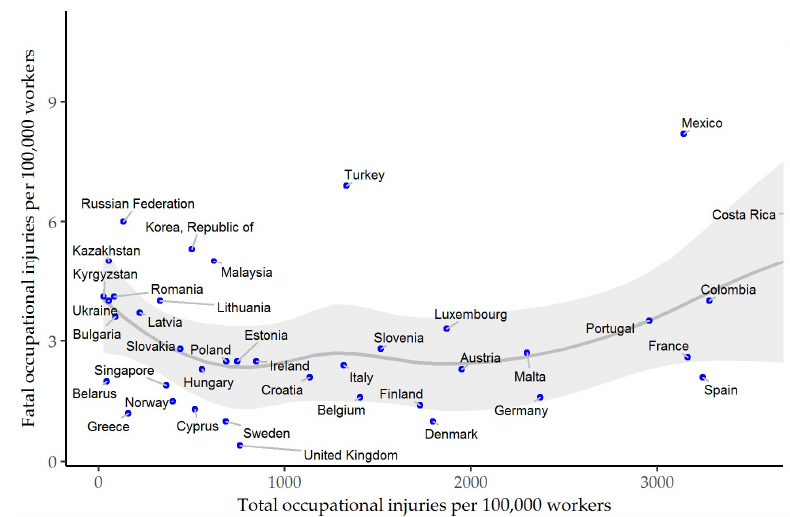
Figure 1. The number of total and fatal occupational injuries per 100,000 workers of each country from the data of ILOSTAT in 2015. Note: The values of Costa Rica are not shown in figure for clarity (Costa Rica: total occupational injury rate = 8922.5; fatal occupational injury rate = 6.9). The grey line indicates the smooth nonparametric curve using a loess smoother (the loess span 0.75) and the grey shadow indicates the 95% confidence interval of smoothed curve. All data sourced from International Labour Organization Database (ILOSTAT)